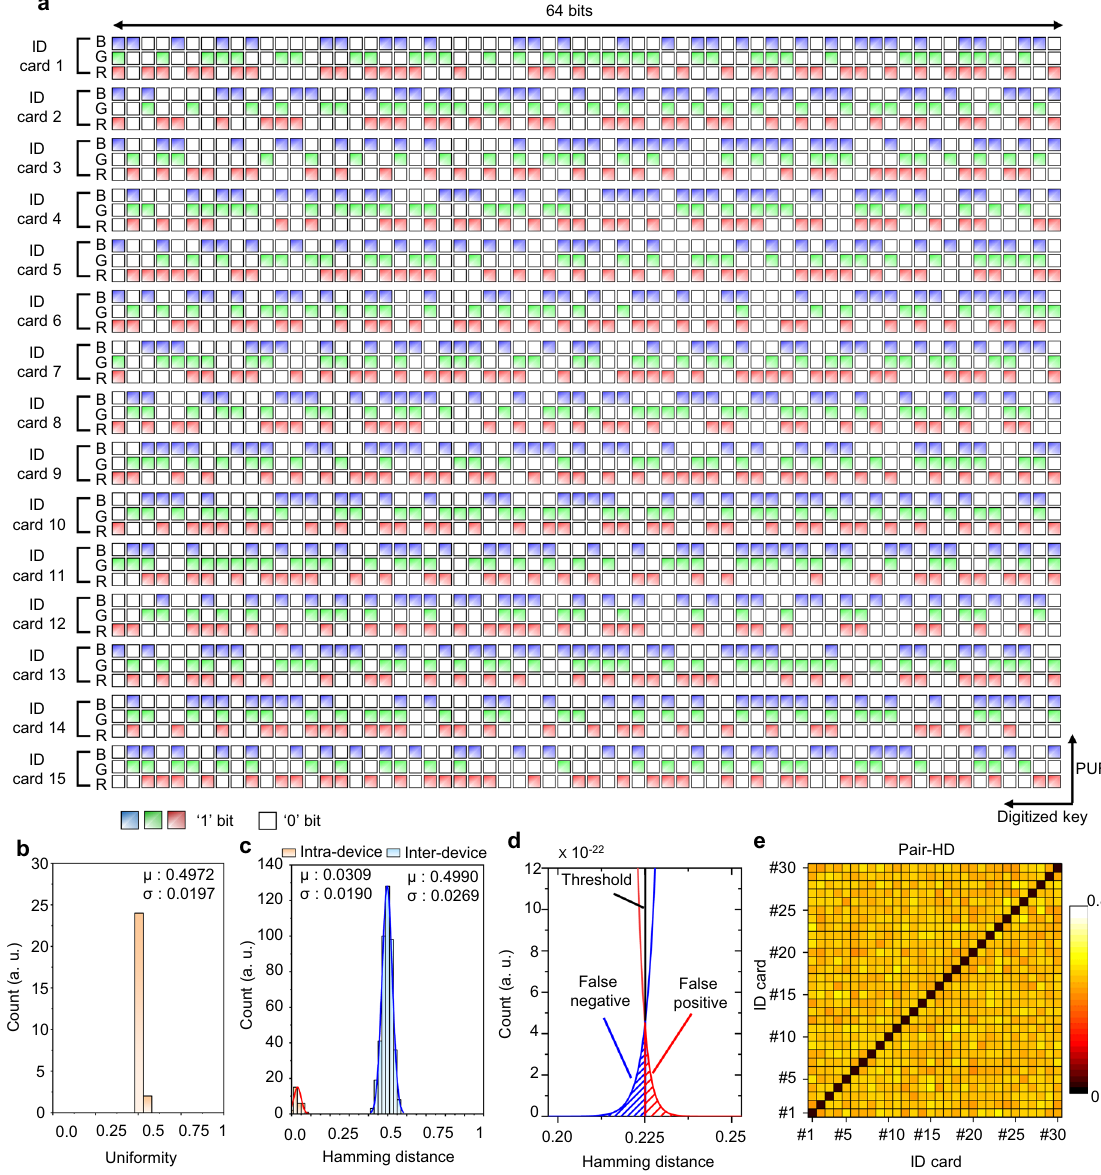
Fig. 5 Generated bits and features of the LOP-PUF. a Fifteen bit sequences obtained by the LOP-PUF for three spectrally separate LEDs. The three LEDs with red (R), green (G), and blue (B) light sources are positioned at an angle in the LOP-PUF to illuminate the light obliquely. A total of the obtained bit sequences (i.e., 1 – 30 of ID cards) are shown in Supplementary Fig. 18. b Bit uniformity of the response bit data with ‘ 0 ’ and ‘ 1 ’ obtained by counting the number of digits for each silk ID card. c Inter-device HD and intra-device HD of each PUF response. d Magni fi ed intra-device and inter-device HD for a threshold of authentication. e 2D correlation of the LOP-PUF using 30 silk ID cards with nine responses. The black solid lines delineate each silk ID card and the color bars indicate the colors of the q different PUF devices, K j is the binary bit of the key in the j th